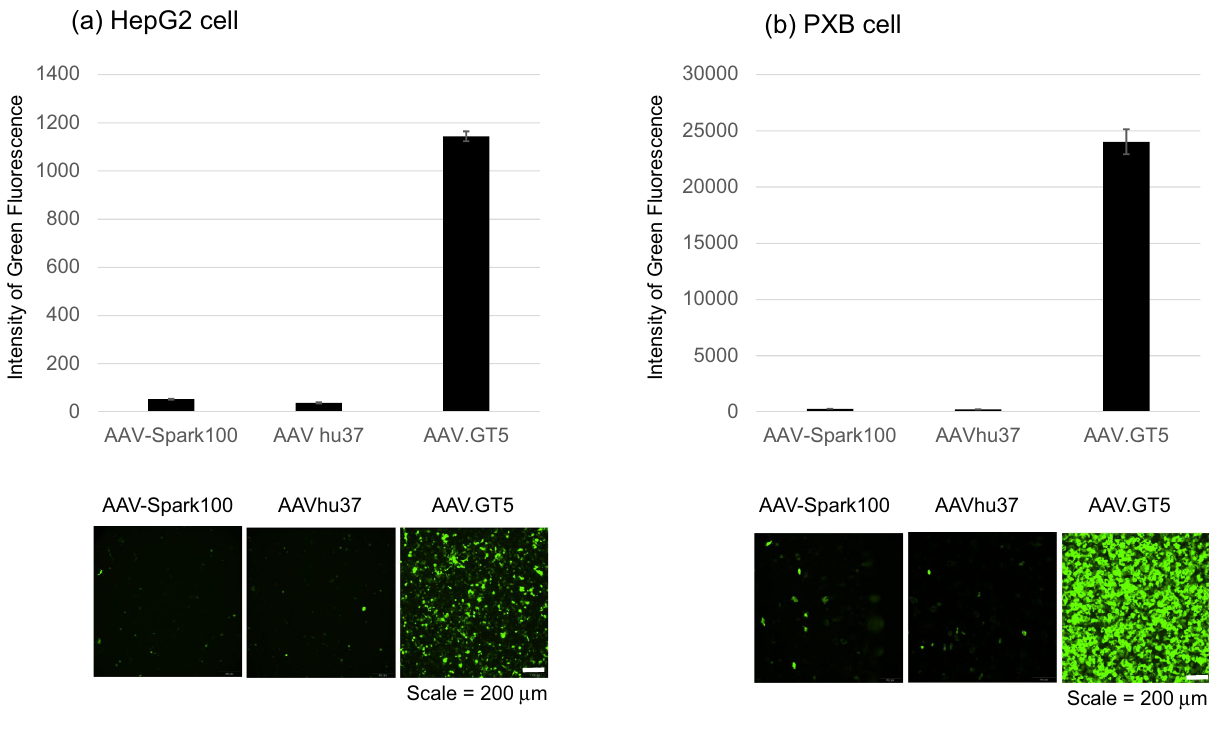
Figure 3. Transduction efficiency of AAV.GT5, AAV-Spark100, and AAVhu37 on human hepatocytes. Nine days after the infection of green fluorescence protein (GFP)-expressing AAV vectors at the 4 × 10 4 of multiplicity of infection, mean fluorescence intensity (MFI) of GFP were measured. The scale of the vertical axis is different for each cell-line. ( a ) HepG2 cells, ( b ) PXB cells. Representative images are shown in the lower panels. Scale bar represents 200 μm.